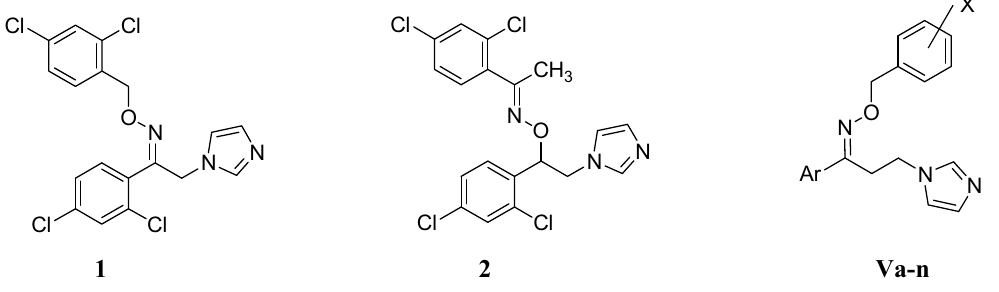
Figure 1. Chemical structures of the antifungal agents 1 and 2 as well as the target compounds Va – n .